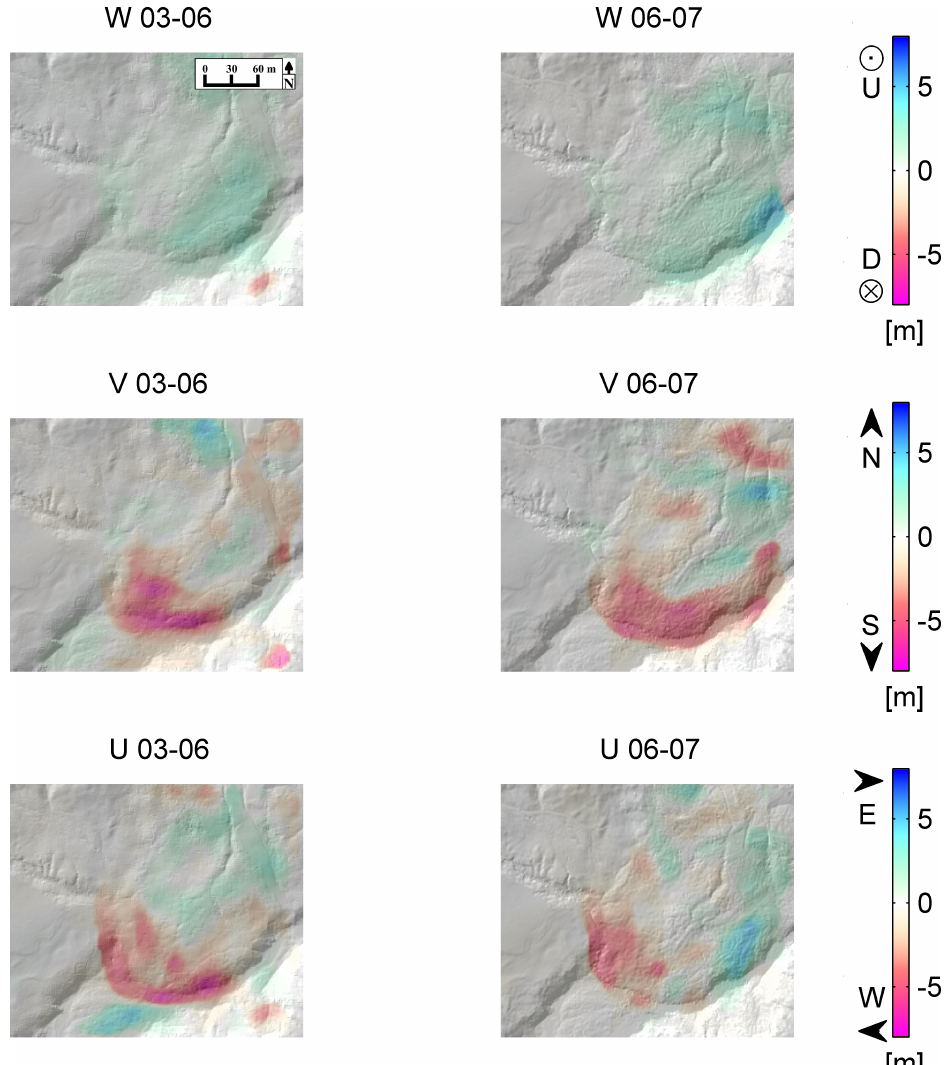
Figure 10. Motion vectors at the toe of the landslide from 2003 to 2007, W . . . elevation change, U . . . west-east motion, V . . . south-north